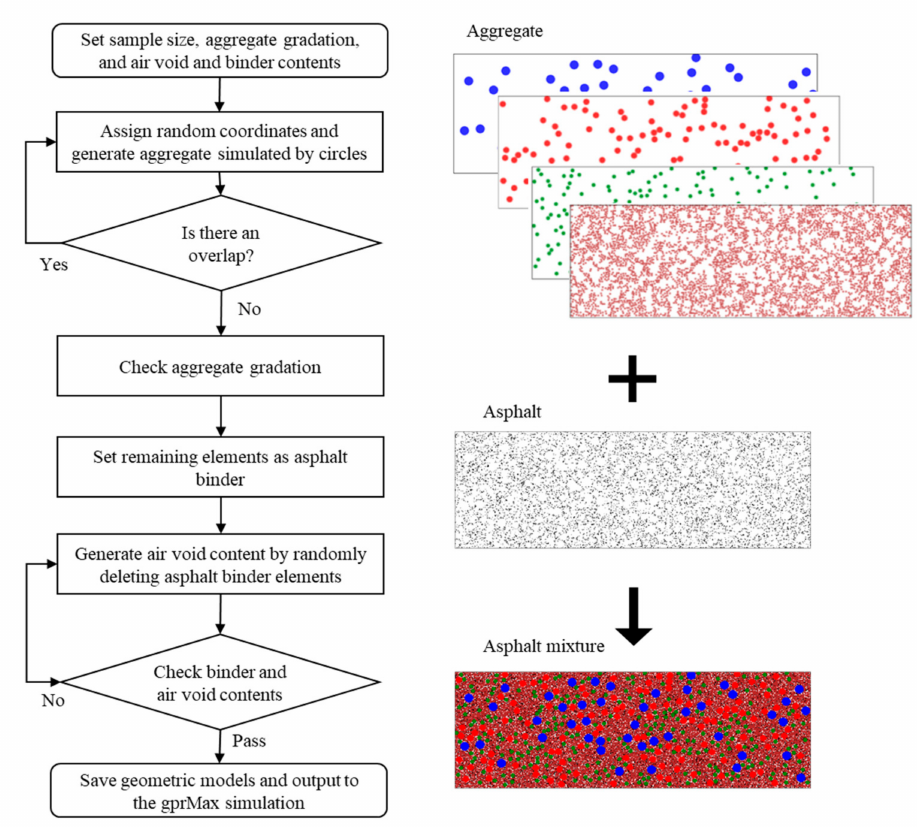
Figure 2. A flowchart of the three-phase asphalt-mixture generation algorithm.